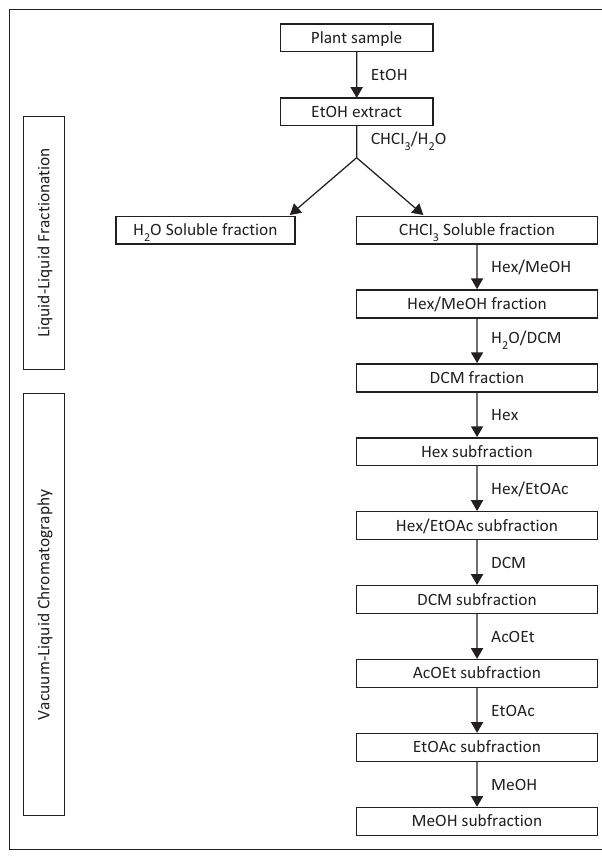
, chloroform; H O, water; Hex, hexane; 3 2